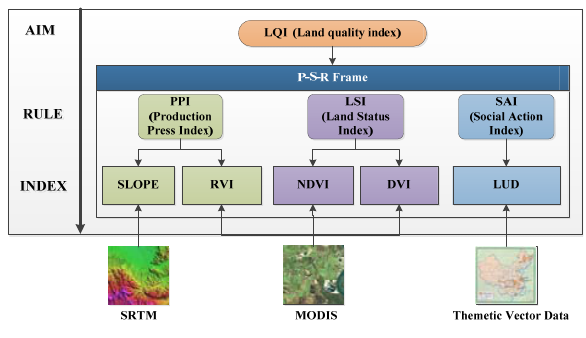
Figure 1. An improved model of CCRR